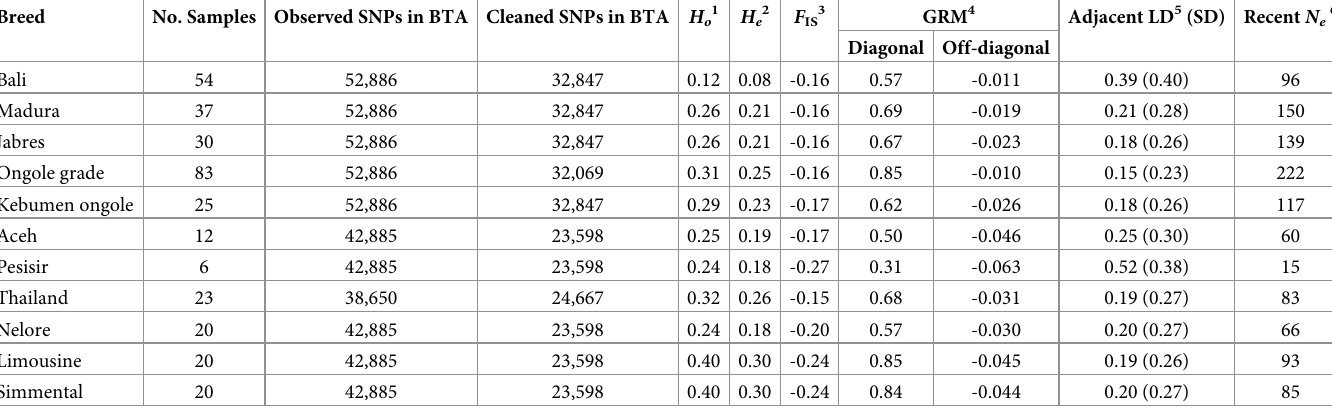
Table 1. Data summary for observed cattle populations.